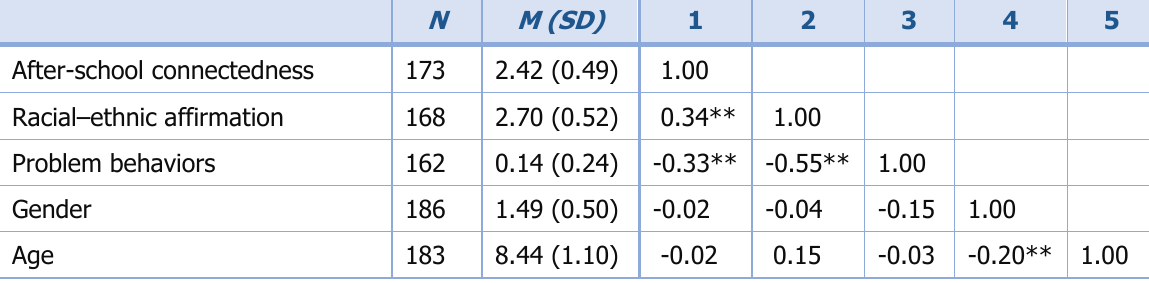
Table 1. Descriptive Statistics and Bivariate Correlations